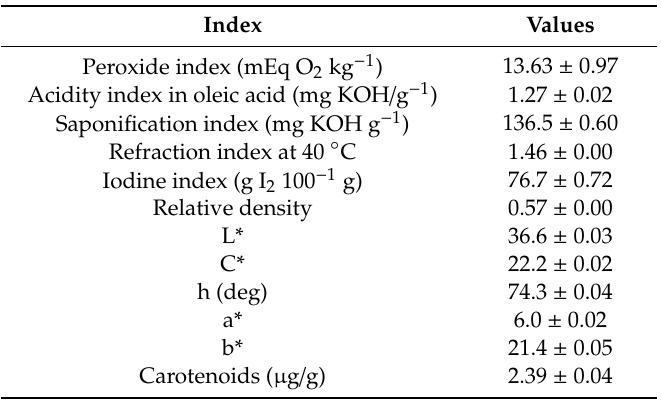
Table 1. Indices of quality and identity of Caryocar brasiliense pulp